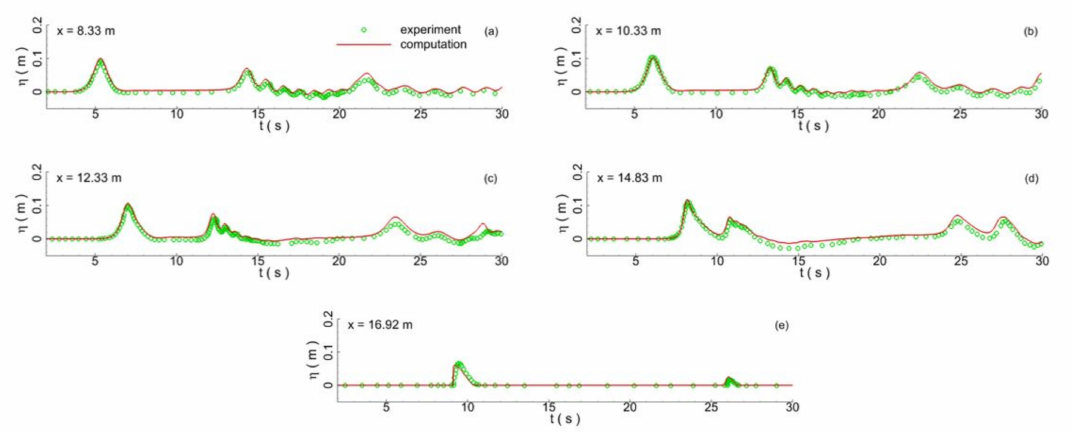
Figure 9. Comparisons of the time series of water surface elevation at different wave gauges; ( a ) WG1;